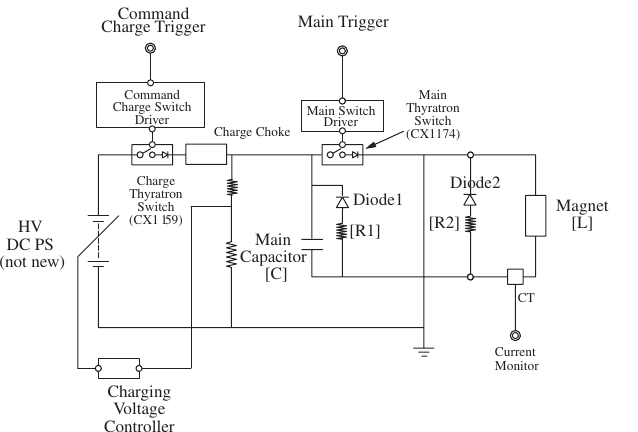
FIG. 16. Conceptual block diagram of the circuit for the pulsed power supply. The power supply consists of two parts: a DC part and a pulser part. Two thyratron switches in the pulser part are used for the charge and the discharge switches. They are driven by the independent trigger signals. The magnet serves as an inductive